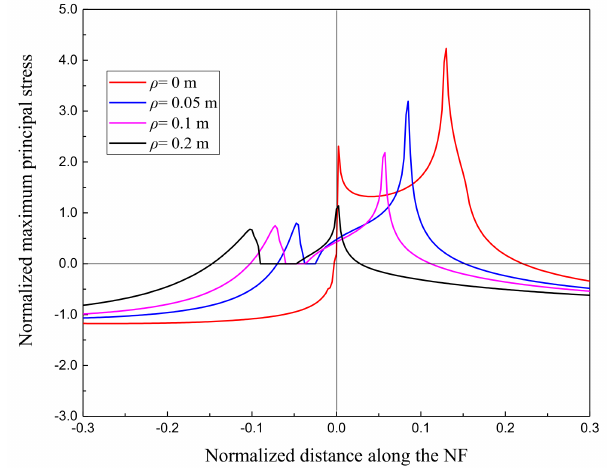
Figure 11. Maximum principal stresses along the NF with different fracture